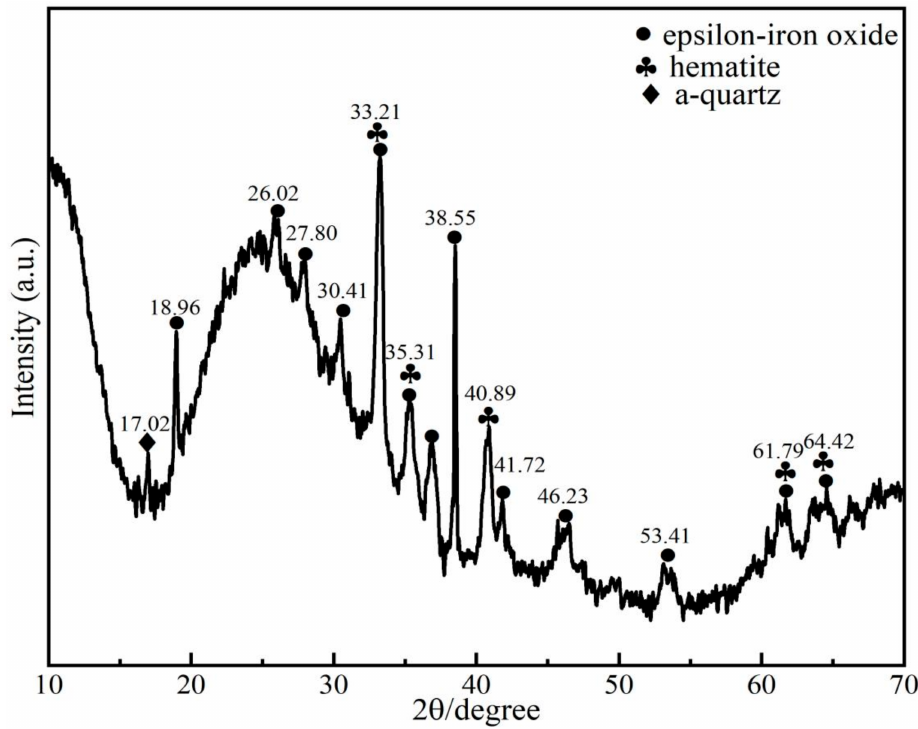
Figure 4. XRD pattern of the glaze